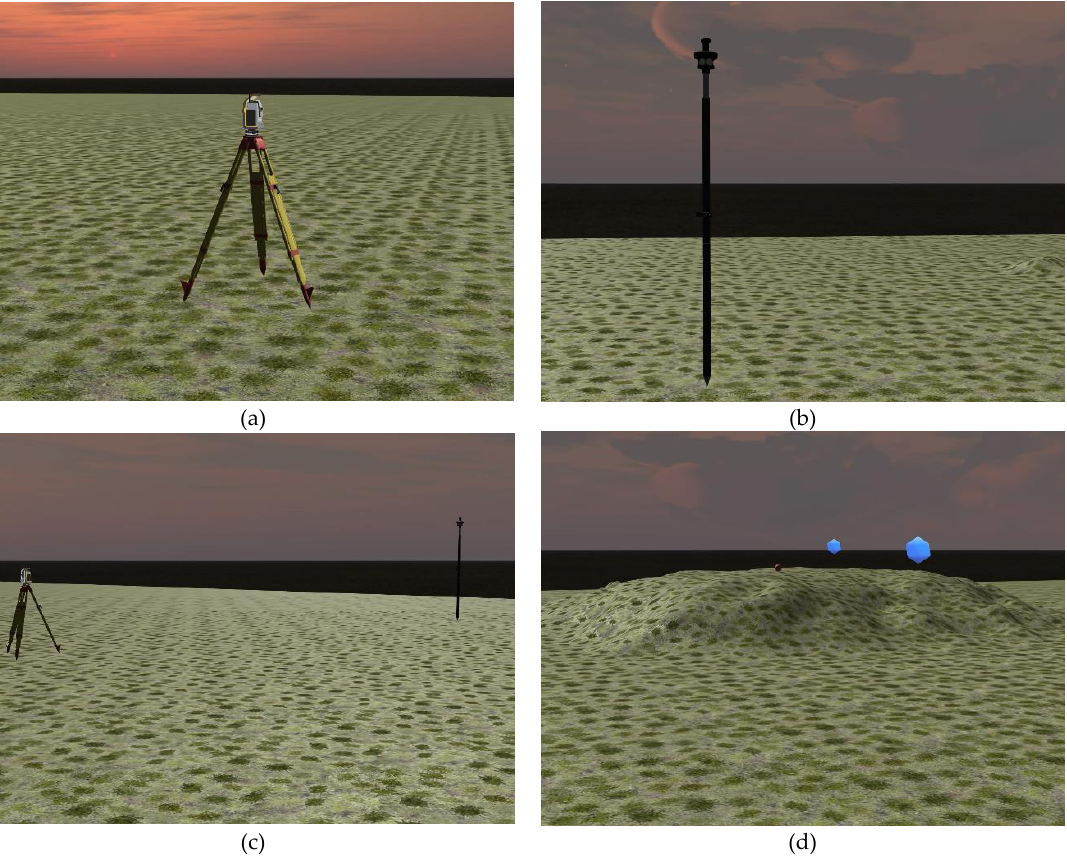
Figure 4. Surveying VR cyberlearning system in action: virtual total station setup ( a ); virtual reflector setup ( b ); virtual measurement ( c ) and measured points locations ( d ).